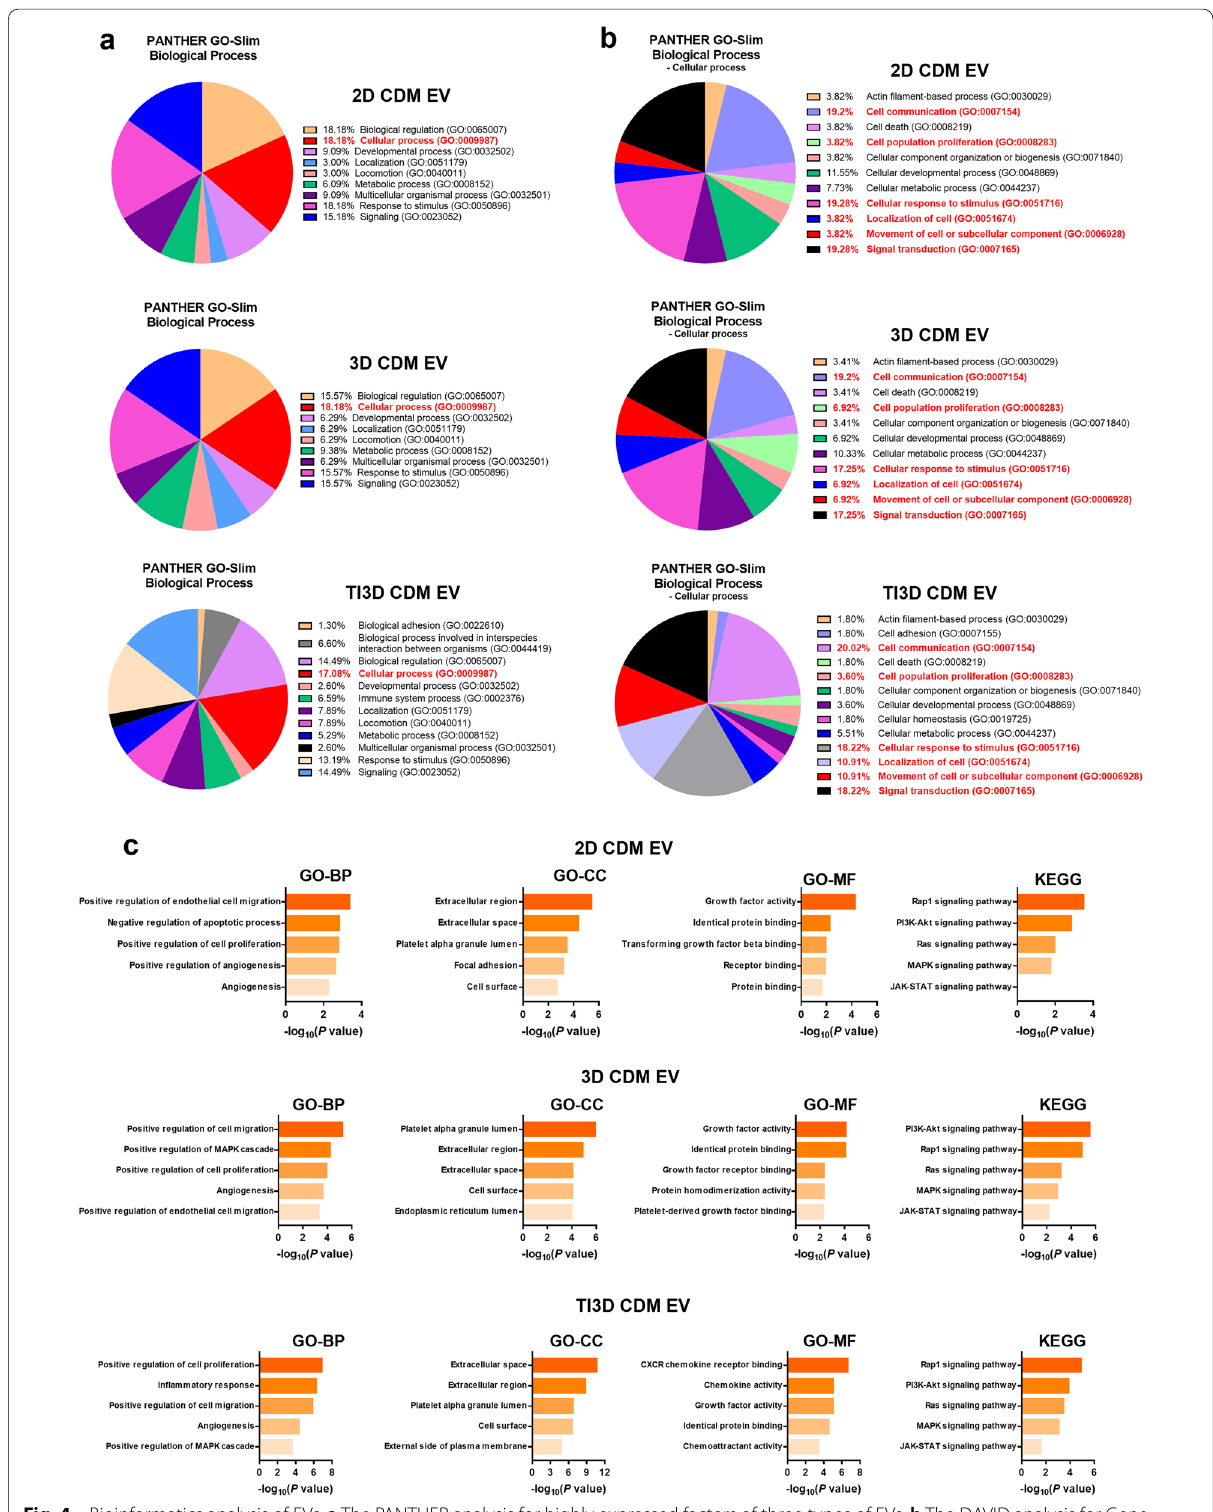
Fig. 4 Bioinformatics analysis of EVs. a The PANTHER analysis for highly expressed factors of three types of EVs. b The DAVID analysis for Gene Ontology (GO)‑BP, GO‑CC, GO‑MF, and Kyoto Encyclopedia of Genes and Genomes (KEGG)